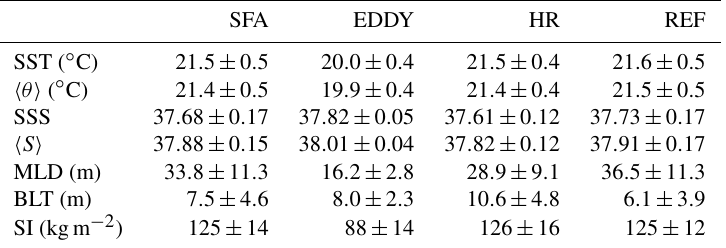
Table 1. Oceanic parameters at the beginning of the simulation (04:00UTC on 7 November) in the different zones (see text).